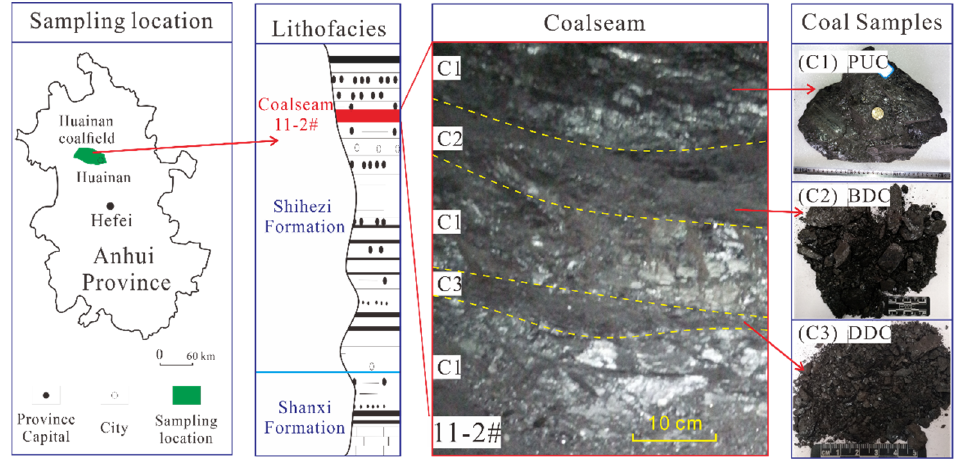
Figure 1. Sampling location, coal seam and samples.